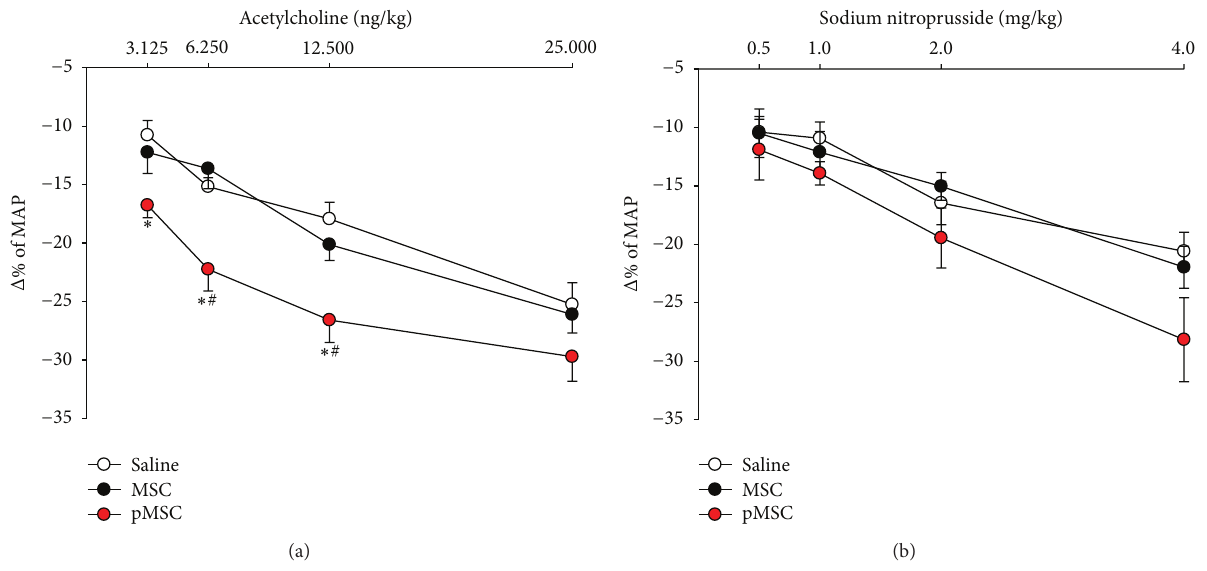
Figure 4: Study of endothelial function. Improvement in endothelial function was analyzed based on the percentage reduction of MAP in response to injections of different doses of acetylcholine (a). Injections of sodium nitroprusside were performed to control the endothelium- independent vasodilator response (b). Values indicated as the mean ± sem. ∗ 𝑝 < 0.05 versus saline; # 𝑝 < 0.05 versus MSC. body weight ratio, compared with saline ( 3.95 ± 0.35 versus 4.36±0.38 , 𝑝 < 0.05 ), but not compared with the MSC group ( 3.95 ± 0.35 versus 4.09 ± 0.26 , 𝑝 = nonsignificant).